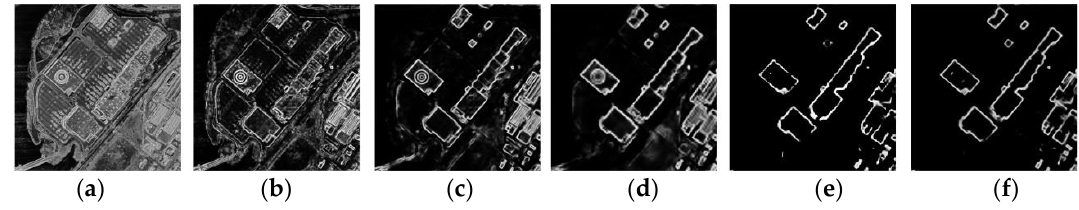
Figure 12. Output images of each stage and fusion output image. From ( a – f ): stage1 output, stage2 output, stage3 output, stage4 output, stage5 output, and fusion output.